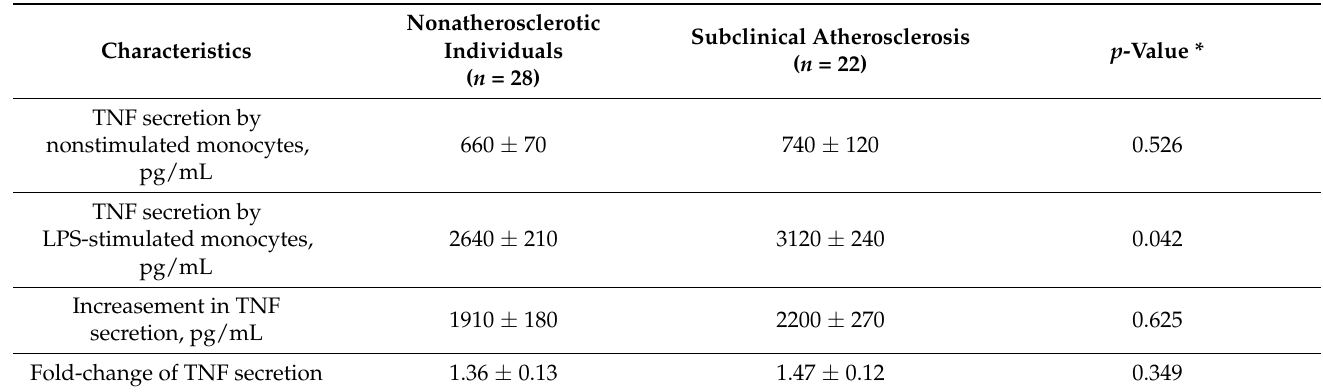
Table A1. Proinflammatory response of circulating monocytes.